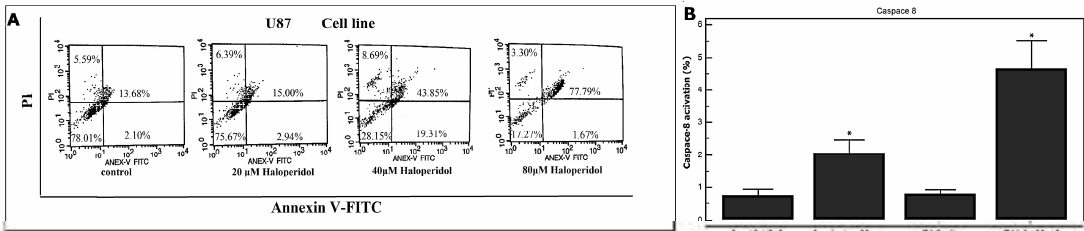
Figure 3. The effect of haloperidol on the induction of apoptosis in U87 glioblastoma cells. ( A ) Flow cytometry was used to analyze the early and late phases of apoptotic cells by annexin V-FITC/PI staining. This assay quantifies live viable cells (left bottom quadrant), apoptotic cells (right bottom and right top quadrants) and necrotic cells (left top quadrant). ( B ) U251 and T98 glioblastoma cells (10,000 cells) were incubated in 24-well plates, and after 24 h, haloperidol (40 μΜ ) was added. After an additional 72 h period, caspase-8 was measured. Significant increase ( p < 0.05) in caspase-8 activation was demonstrated in both cell lines.